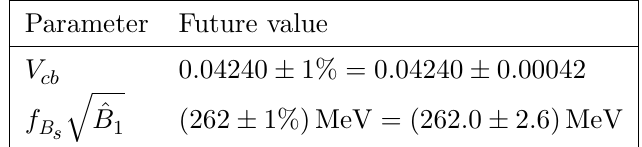
Table 1 . Future values for the two most important parameters for the error on (cid:1) M (our explicit future inputs are given in table 1, with all others staying the same as at present), we expect that (cid:1) M will be predicted with an uncertainty of only (cid:6) 0 : 5 ps (cid:0) 1 by s 2025, yielding eq. (1.9).